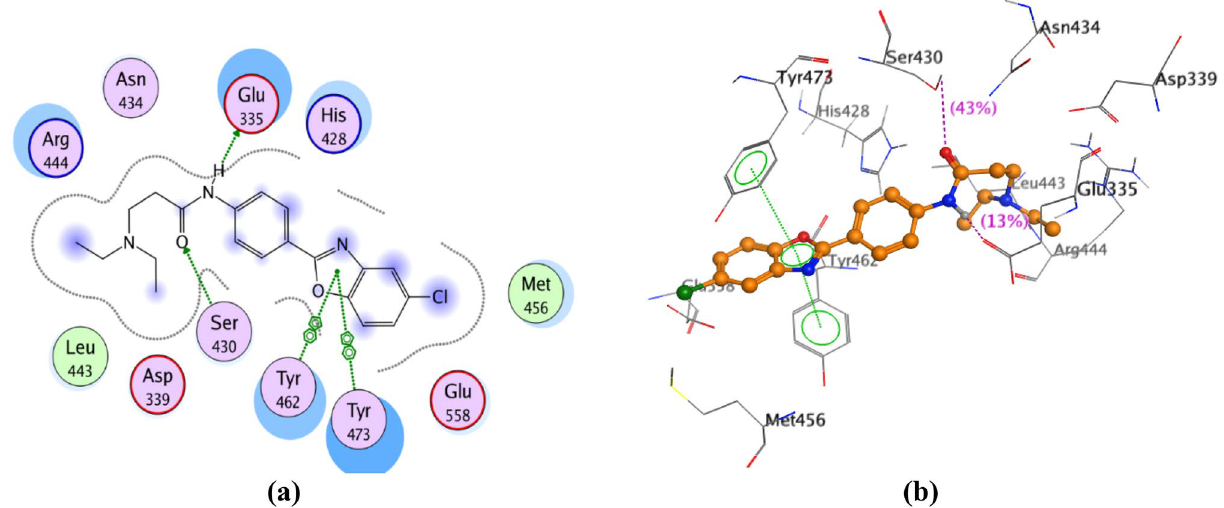
Figure 12. ( a ) 2D view of the interactions between 27 and PARP-2 enzyme active site. ( b ) 3D view of the interactions between 27 and PARP-2 enzyme active site.